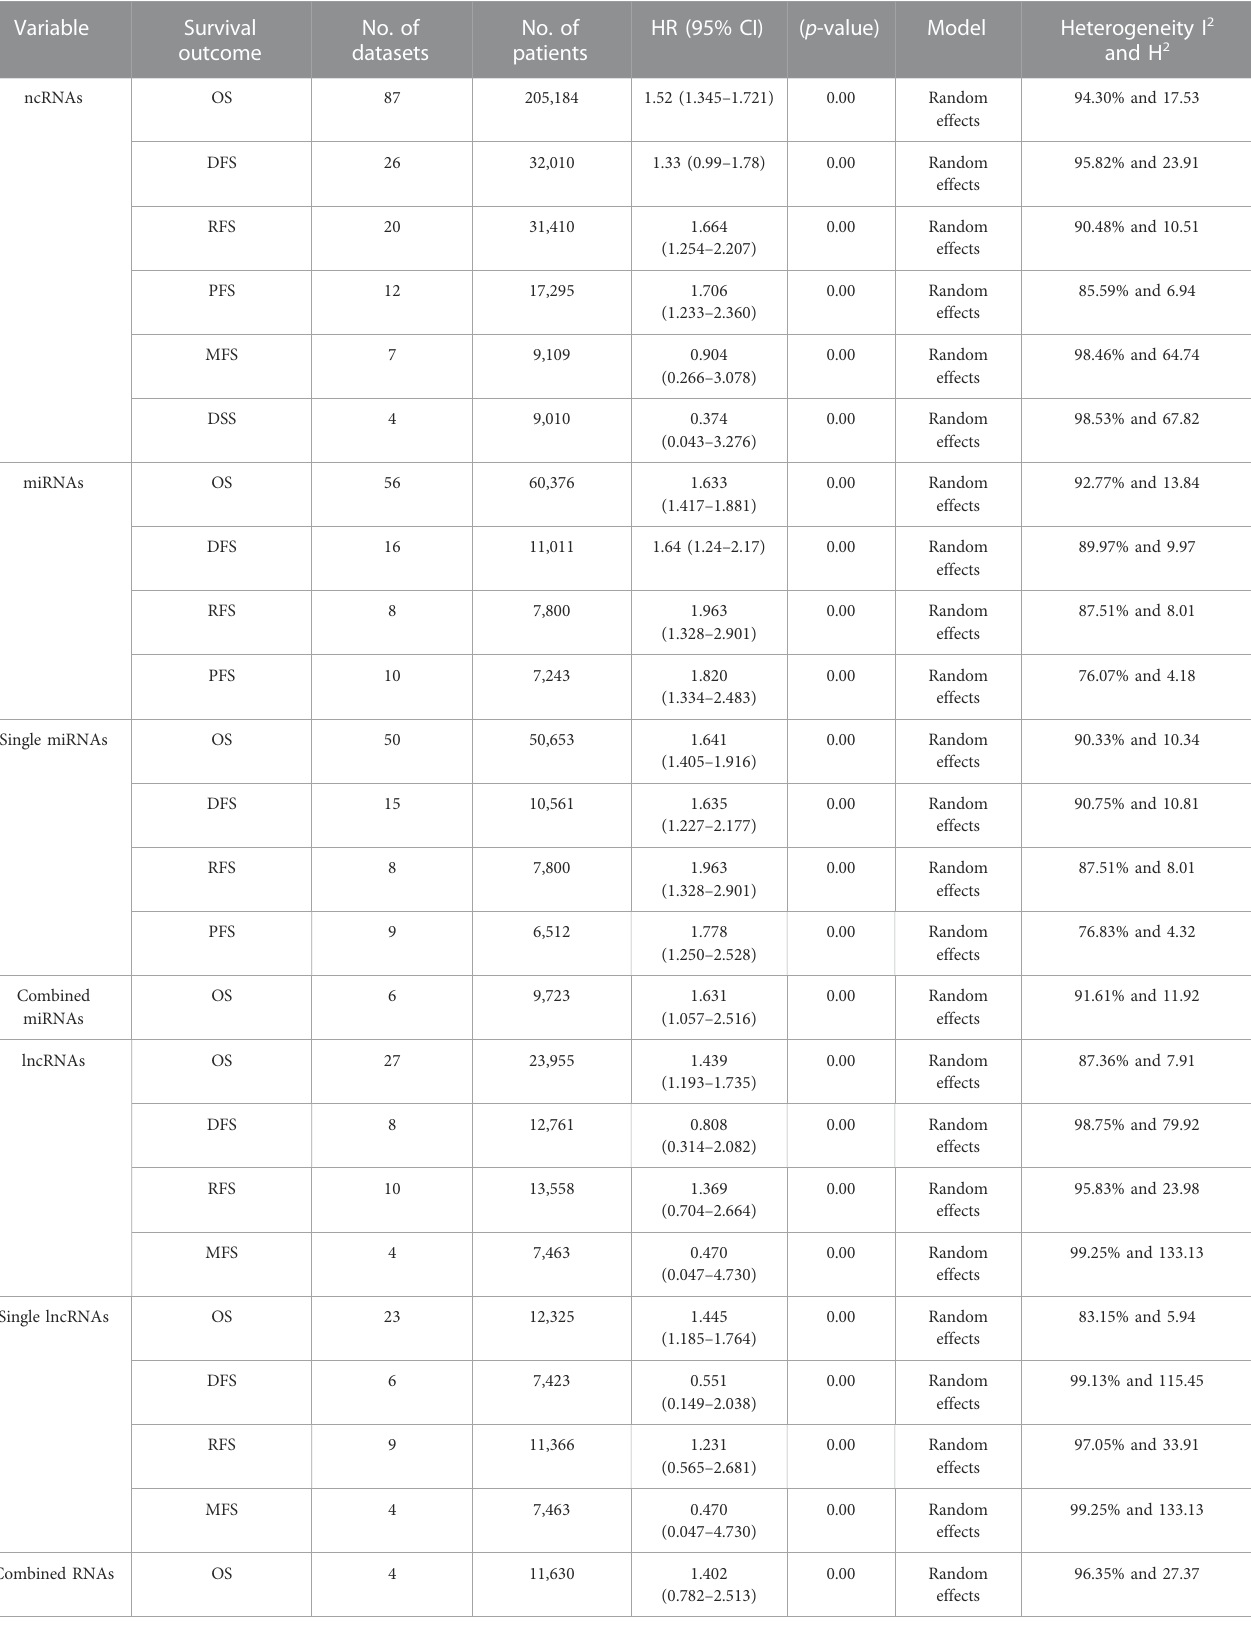
TABLE 1 Prognostic value of ncRNA expression in breast